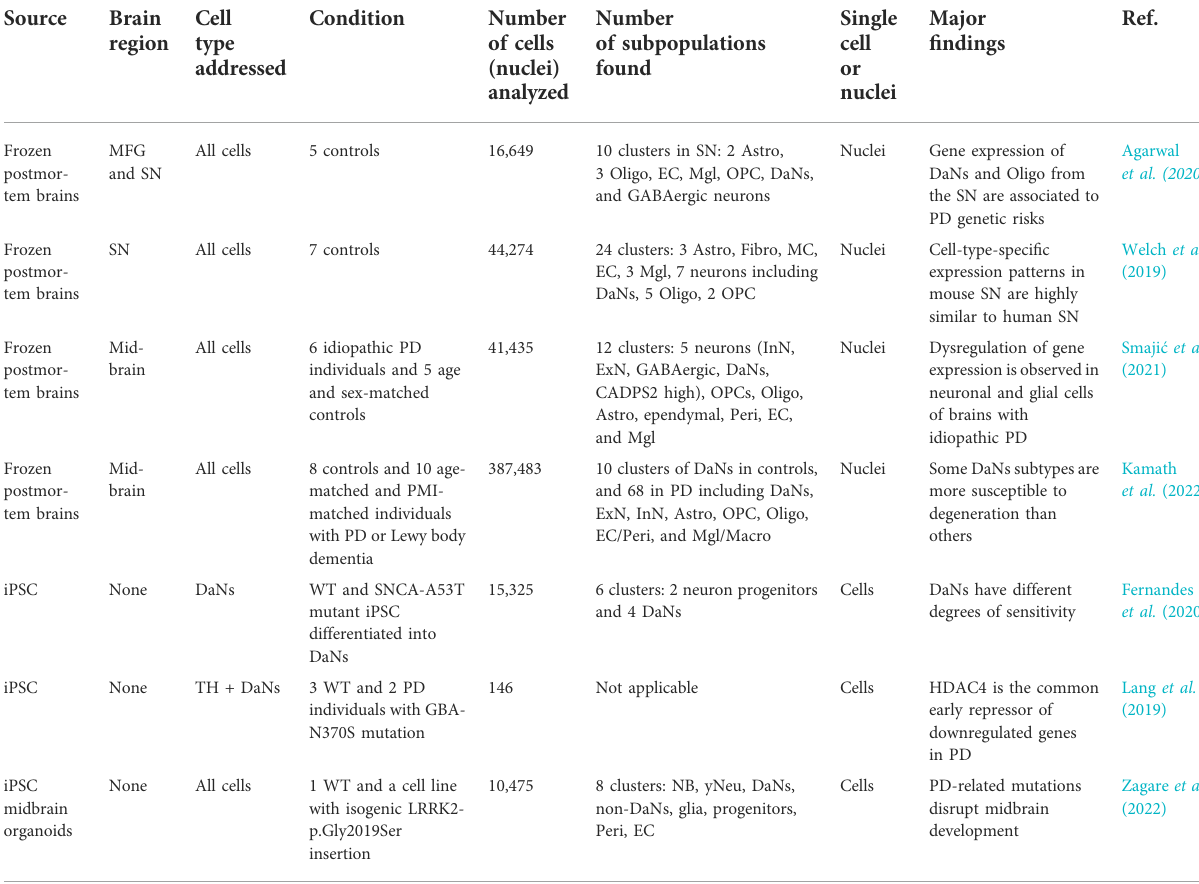
TABLE 2 Selected examples of recent scRNA-seq or snRNA-seq studies in PD. Middlefrontal gyrus (MFG), and substantia nigra (SN). Oligodendrocyte precursor cells (OPC), oligodendrocytes (Oligo), astrocytes (Astro), microglia (Mgl), macrophages (Macro), inhibitory neurons (InN), excitatory neurons (ExN), endothelial cells (EC), dopaminergic neurons (DaNs), fi broblasts (Fibro), mural cells (MC), pericytes (Peri), neuroblasts (NB) and young neurons